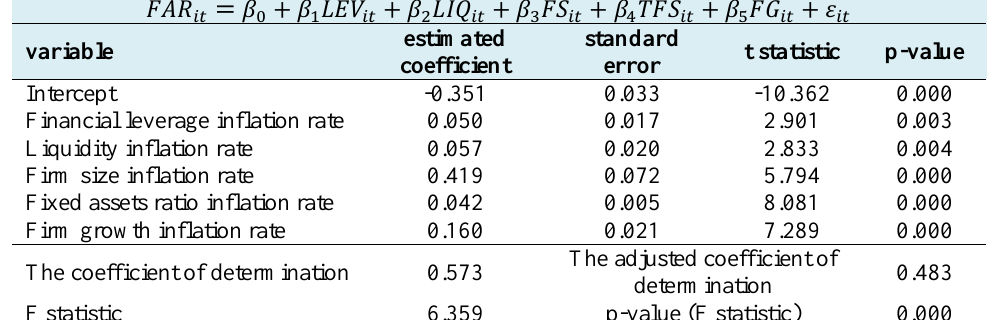
Table 23. The results of estimating the second model of research in the BSE (considering the effects of the inflation